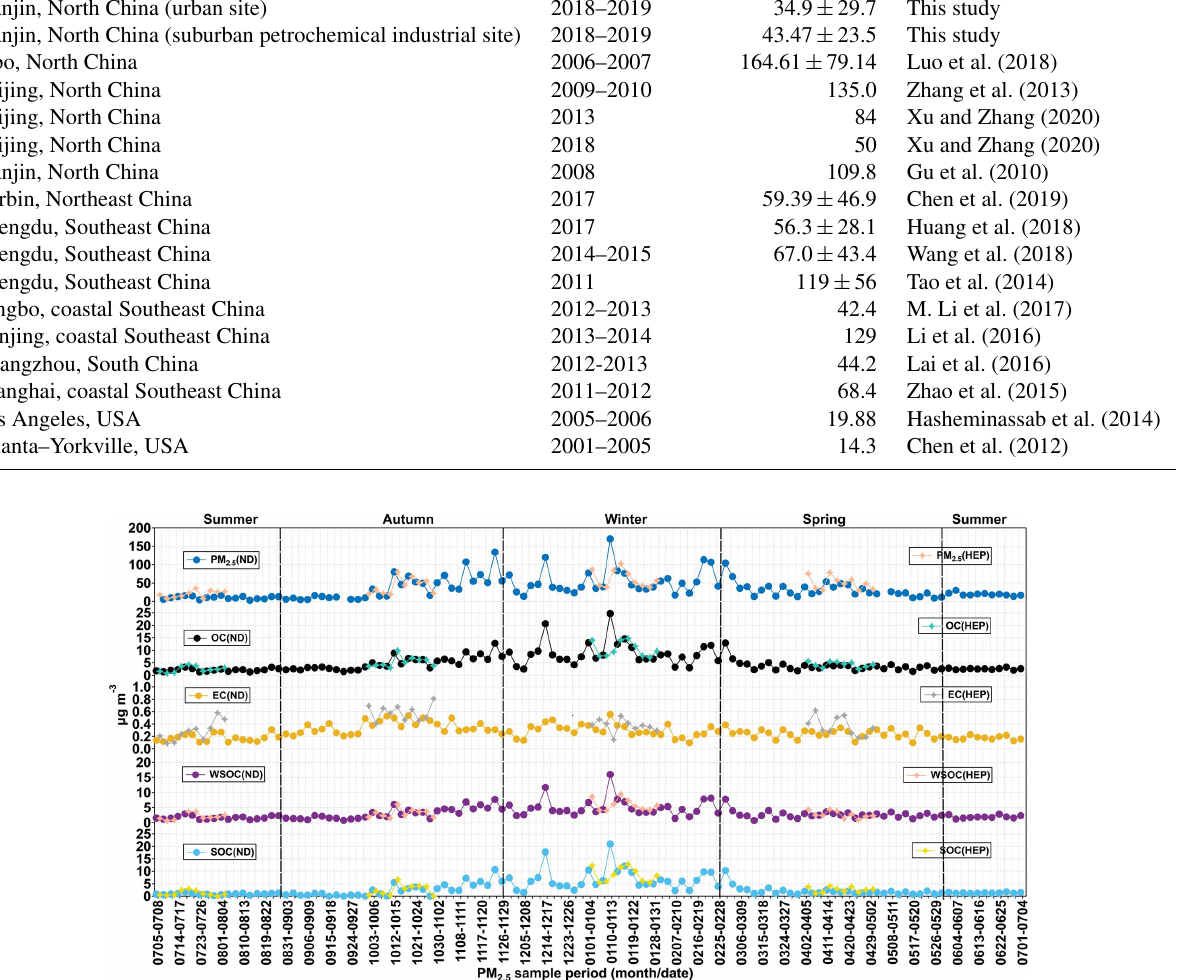
Table 2. PM 2 . 5 mass concentrations in Tianjin and those reported at other different locales in China and around the world. City/nation